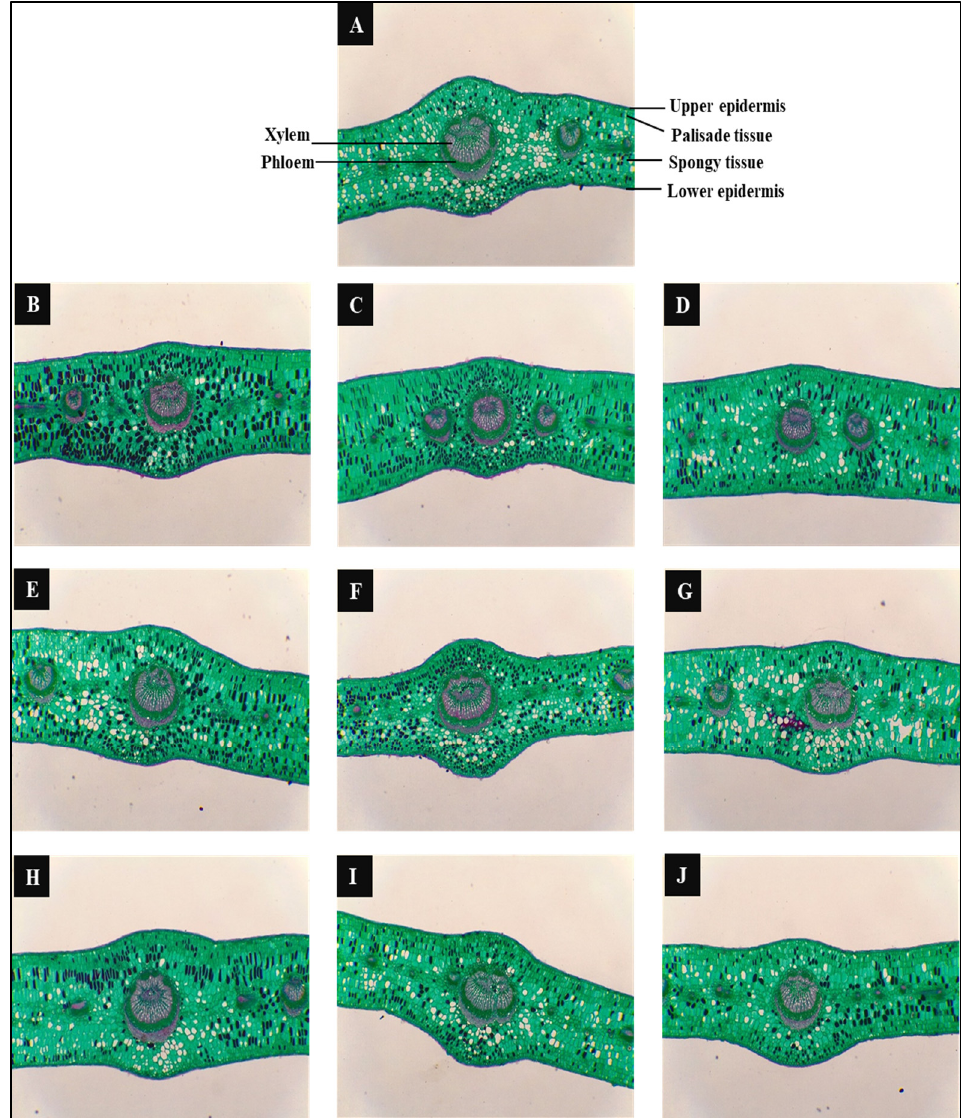
Figure 11. Microphotographs of transverse sections through the blade of leaves on the median portion of jojoba plants (135 days from the beginning of applying treatments) as affected by salinity and proline. ( A ) Control “tap water” without proline application; ( B ) 5000 ppm salinity without proline application; ( C ) 10,000 ppm salinity without proline application; ( D ) 15,000 ppm salinity without proline application; ( E ) 5000 ppm salinity with 300 ppm proline application; ( F ) 10,000 ppm salinity with 300 ppm proline application; ( G ) 15,000 ppm salinity with 300 ppm proline application; ( H ) 5000 ppm salinity with 450 ppm proline application; ( I ) 10,000 ppm salinity with 450 ppm proline application; ( J ) 15,000 ppm salinity with 450 ppm proline application. (Obj. × 4 and Oc. × 10.).